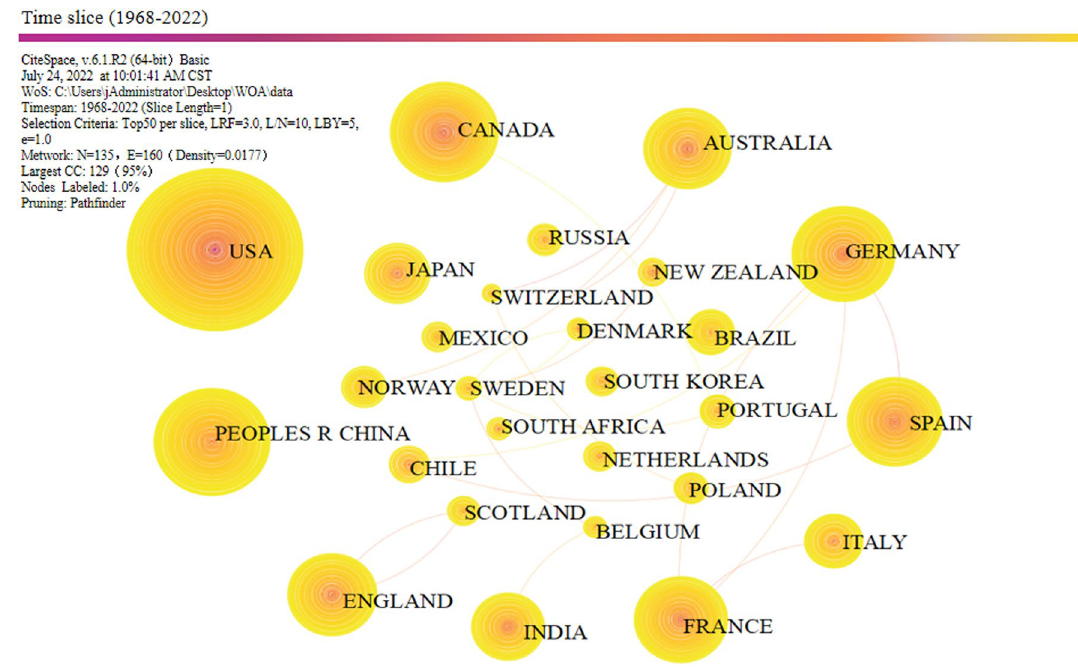
Fig. 3 Network plot of national concern and international cooperation based on the WOS database